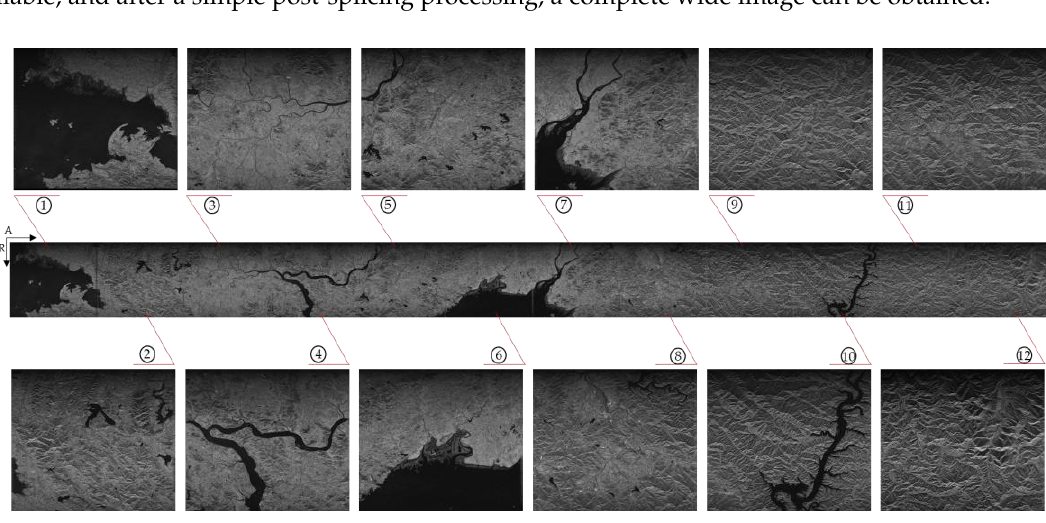
Figure 13. The continuous imaging results of 12 images.